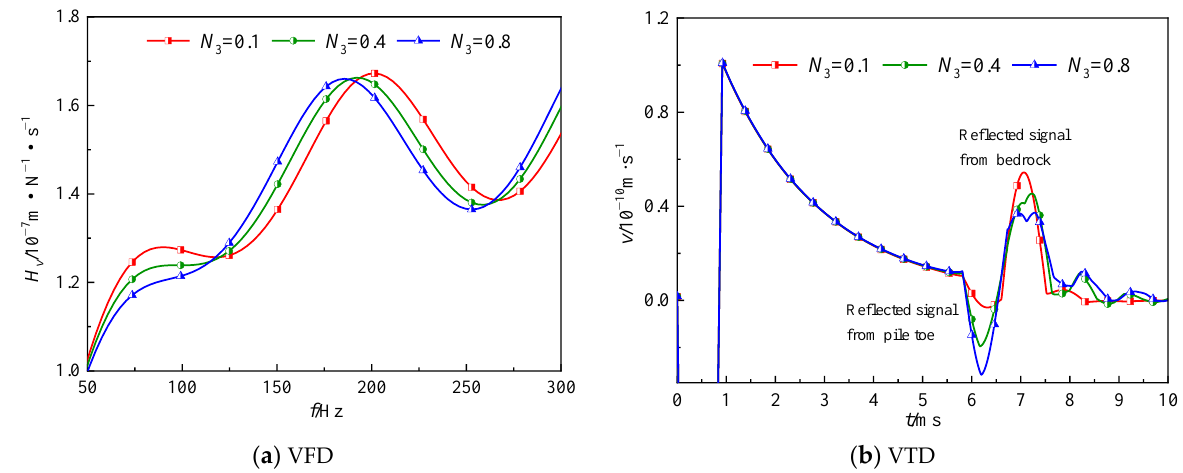
Figure 9. Effect of the porosity of the pile end soils on pile vertical vibration velocity.